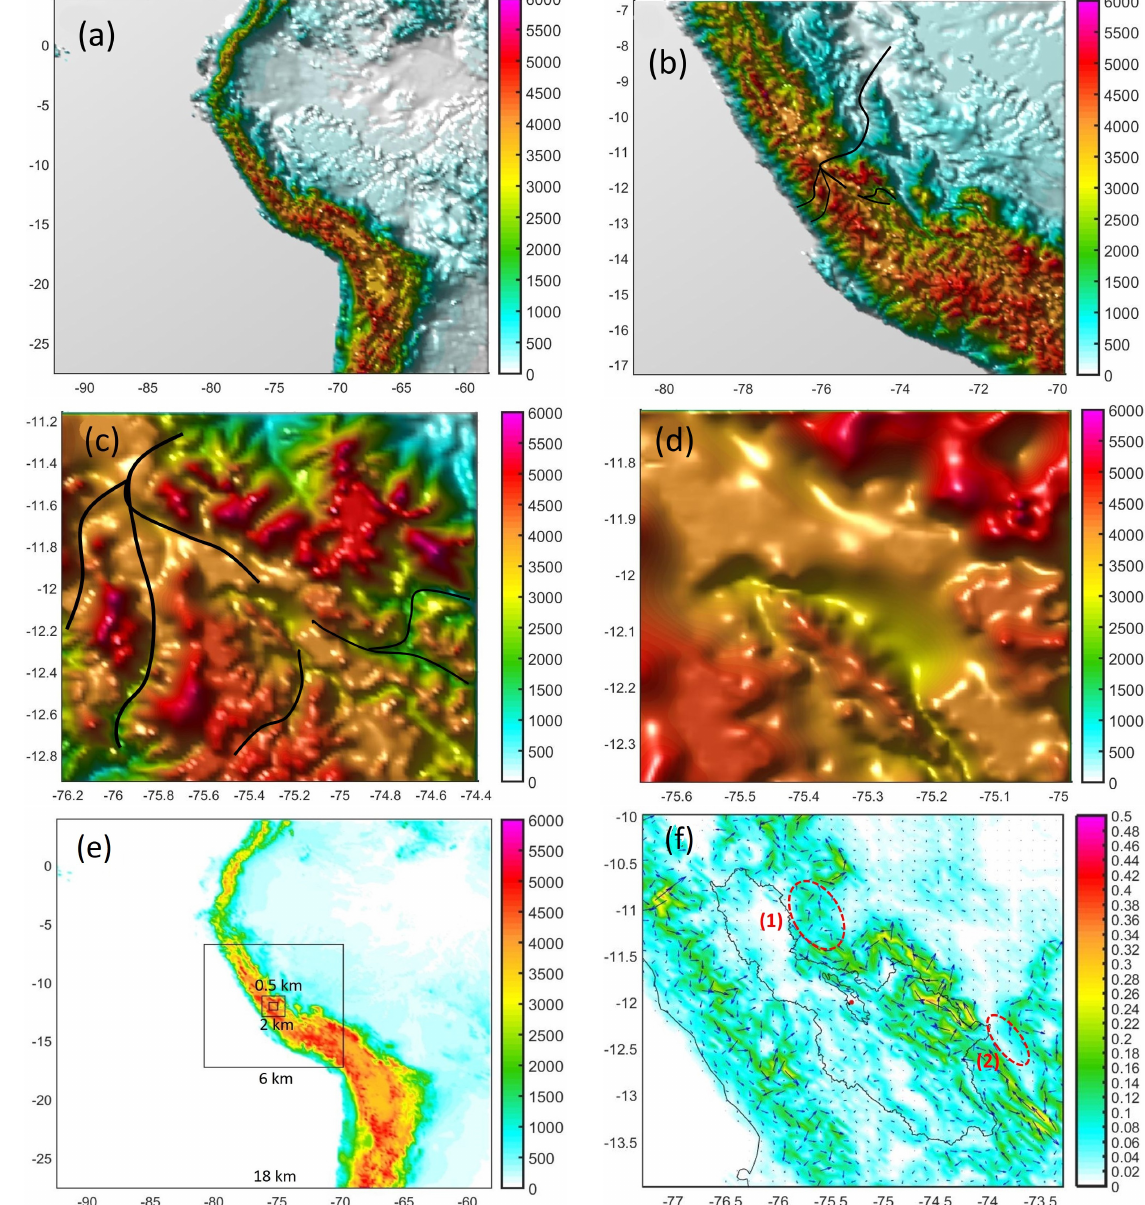
Figure 2. Domains and topography for the resolutions of ( a ) 18 km-WRF; ( b ) 6 km-WRF; ( c ) 2 km-WRF and ( d ) 0.5 km-ARPS. The colorbar indicates the altitude of topography in meters. The range of altitudes around the Mantaro valley is between 3000 m and 5500 m. The black lines indicate the passes around the Mantaro valley; ( e ) Domains for model simulations and ( f ) local terrain slope for the resolution of 6 km around the Mantaro basin. Red dashed circles indicate regions of low topographic gradient (adimensional). Longitudes and latitudes are